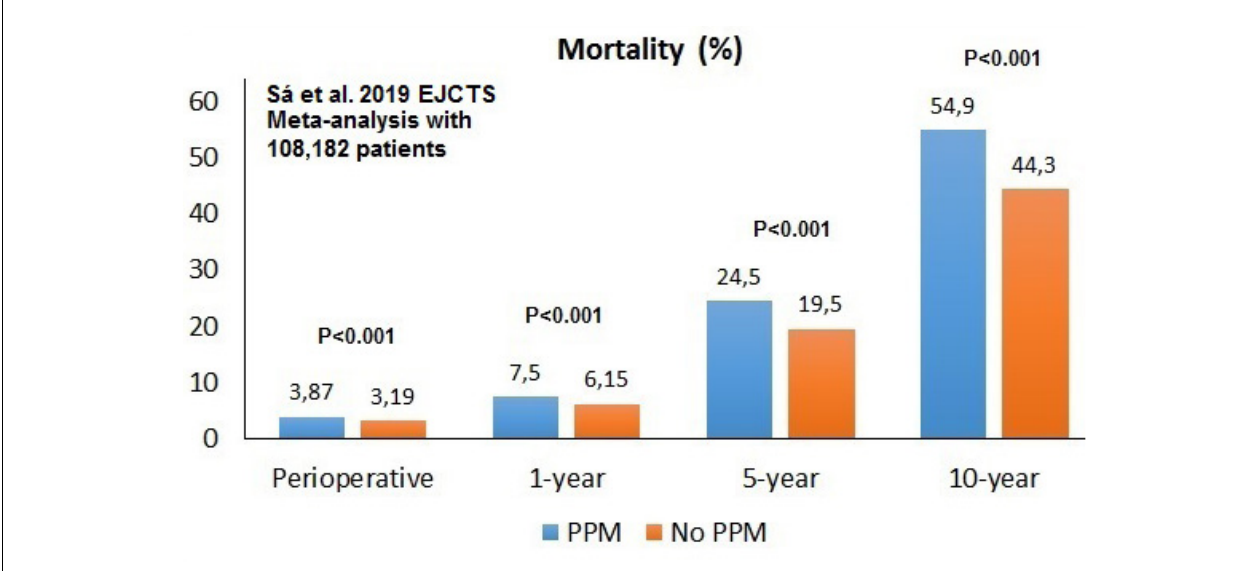
Fig. 2 - Mortality rates – Largest meta-analysis published up to